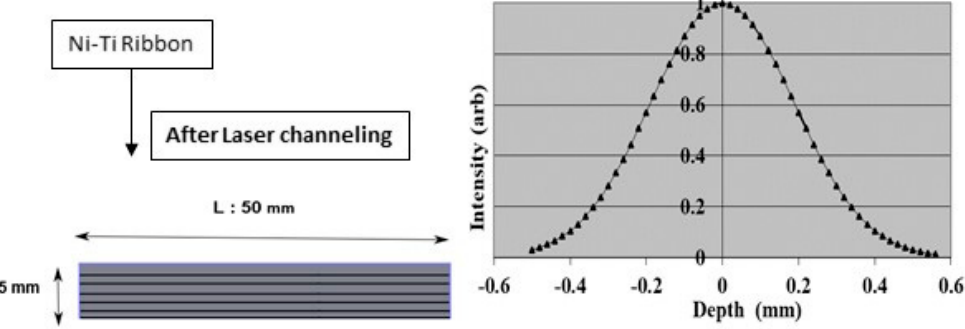
Figure 3. Channel on the Ni-Ti ribbon and its laser intensity versus depth of the Gaussian profile for the surface pattern.